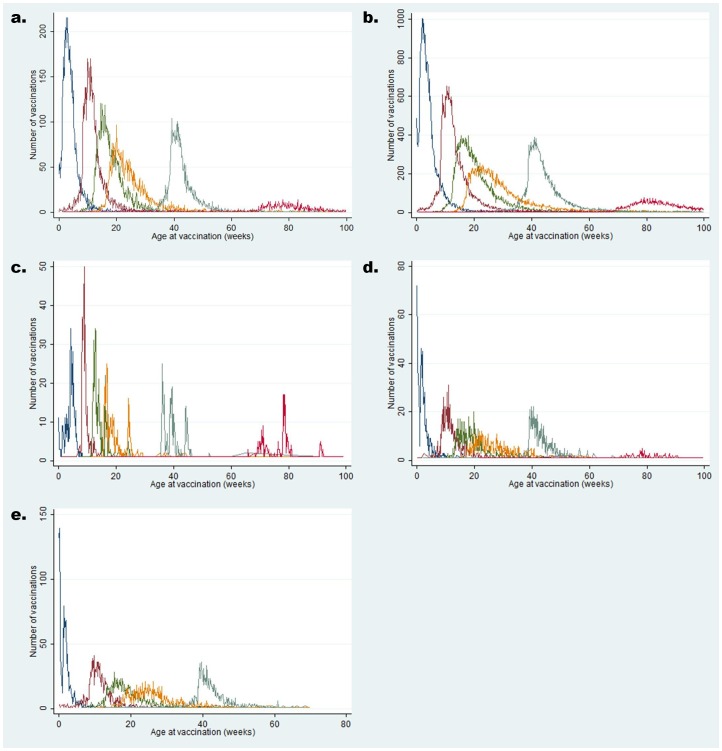
Frequency distribution of number of vaccinations received by age at vaccination (in weeks) for each of the study sites: a) North Bank region (2005–2012), b) South bank of the Upper River Region (2005–2012), c) West Kiang, Lower River Region (2005–2012), d) Western Health Region (June 2010), e) Greater Banjul Health facilities (2010–2011).Blue line: Proportion vaccinated with BCG vaccine. Brown line: Proportion vaccinated with 1 dose of DPT vaccine. Green line: Proportion vaccinated with 2 doses of DPT vaccine. Orange line: Proportion vaccinated with 3 doses of DPT vaccine. Blue/Green line: Proportion vaccinated with measles vaccine. Red line: Proportion vaccinated with DPT booster.